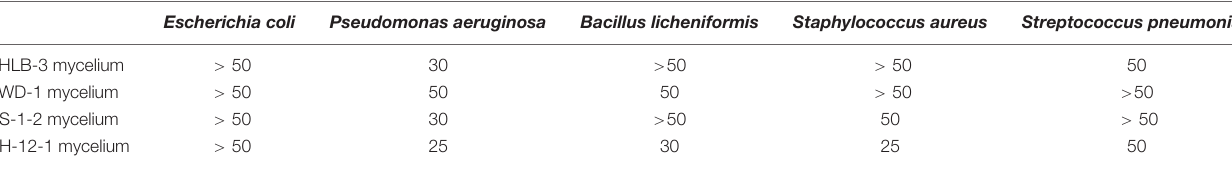
TABLE 5 | Determination of Minimum inhibitory concentration (MIC) ( µ